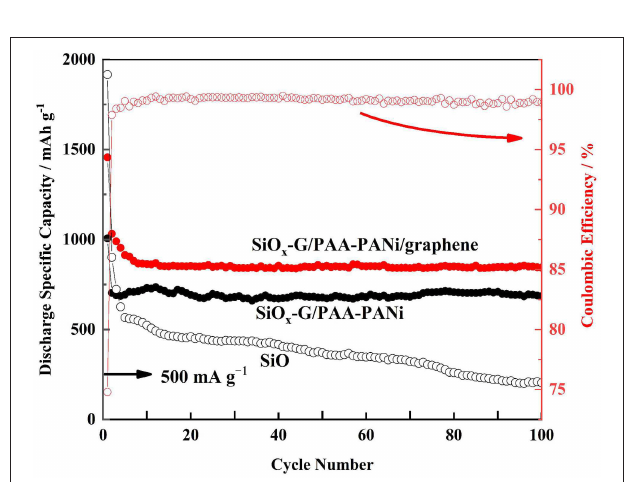
FIGURE 9 | Long-time cycling performances (discharge capacities) of SiO x -G/PAA-PANi/graphene, SiO x -G/PAA-PANi, and SiO under the current density of 500mA g − 1 .